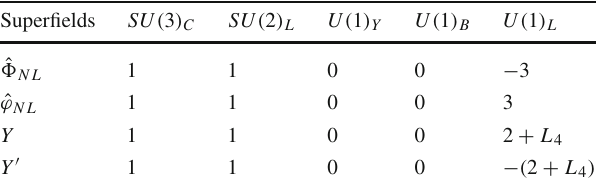
Table 2 The new introduced superfields in the EBLMSSM beyond BLMSSM